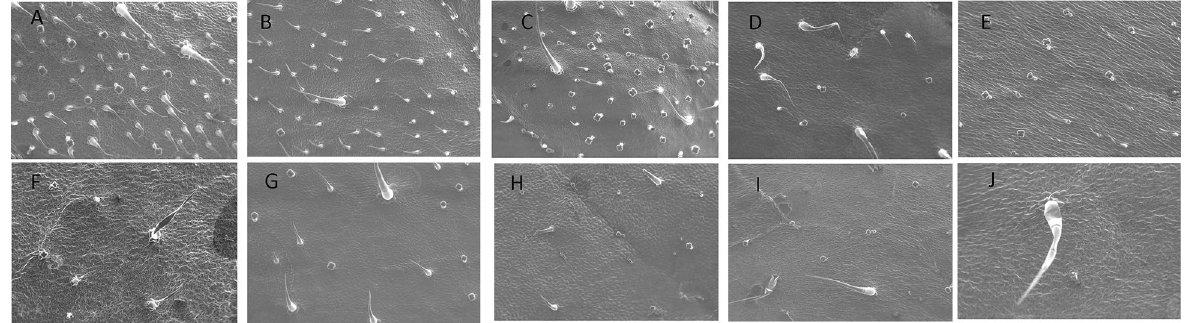
Fig. 1 Scanning electron microscope (SEM) images captured at 100 Pink tiger; D, Black krim; E, Big beef; F, Pink berkeley; G, Tidy treats; H, Purple bumble bee; I, Indigo cherry drops; J, Black